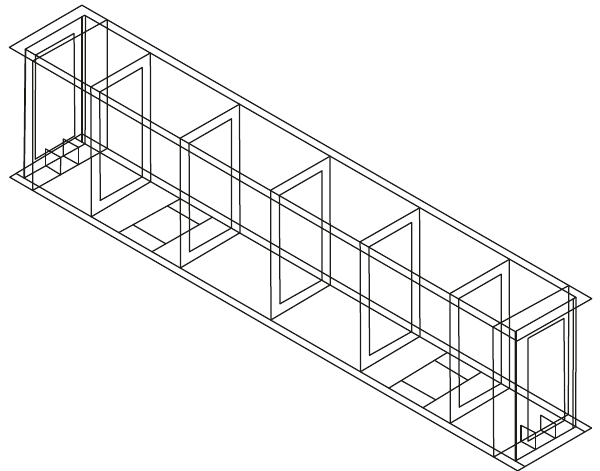
Figure 3: The model of the narrow